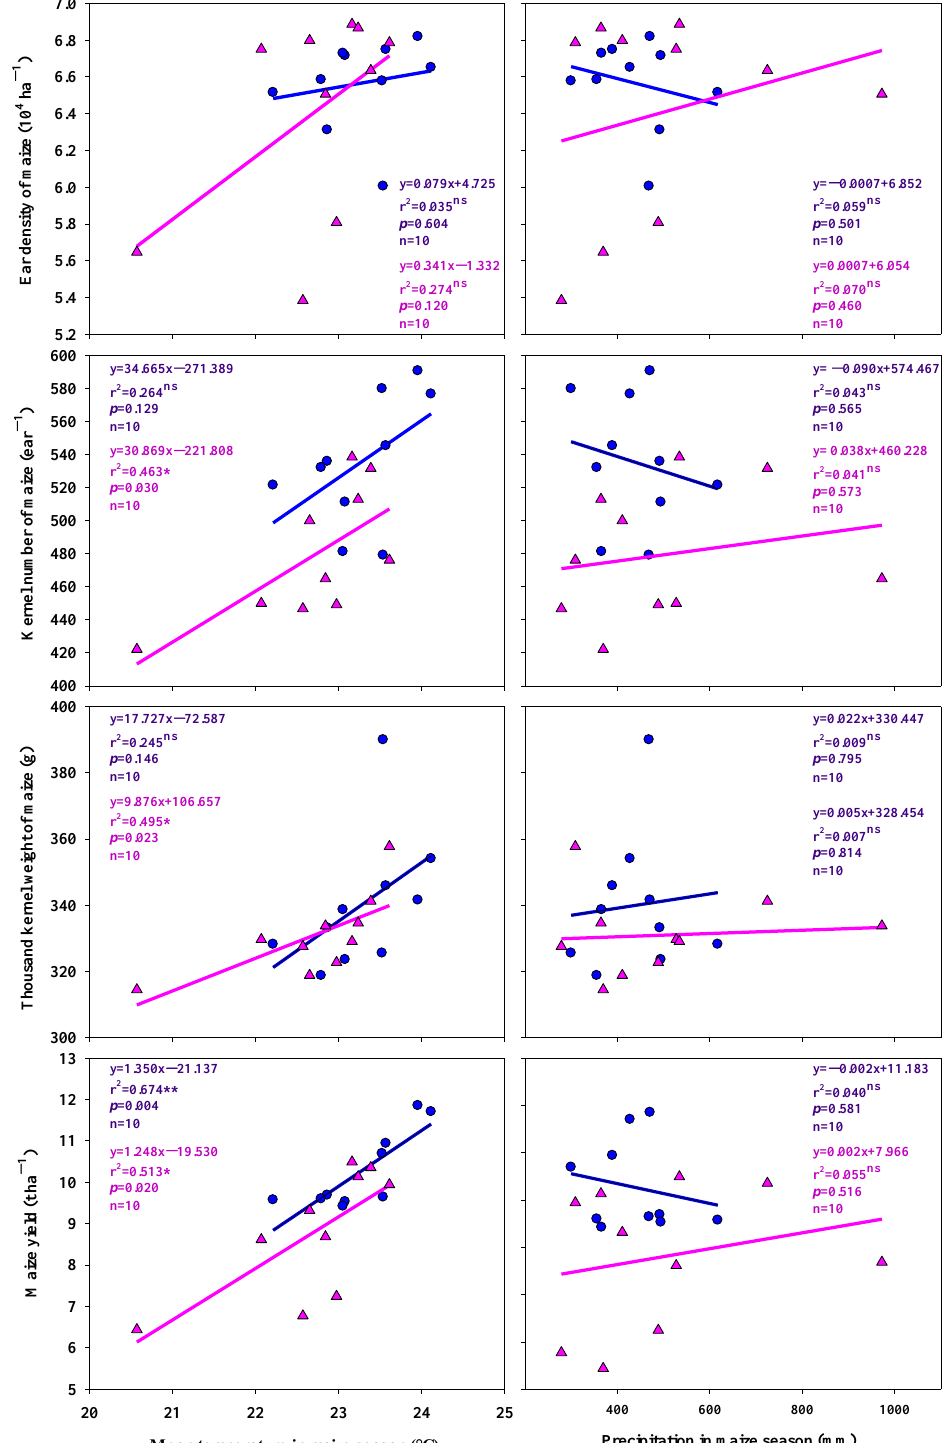
Figure 10. Correlation between maize yield, yield components and mean temperature and precipi- tation in the maize season. The blue circles, lines, and formulas represent the data of the Tai’an experimental site, and the pink circles and lines represent the data of the Longkou experimental site. r: correlation coefficient; p : significance level; n: sample size; **: significant at p < 0.01; *: significant at p < 0.05 . ns : not significant.